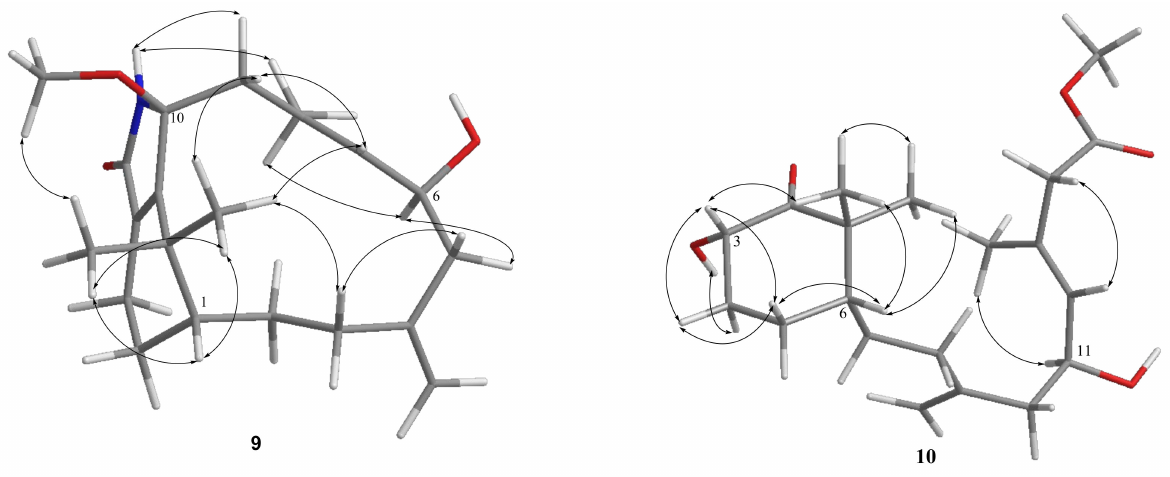
Figure 9. Selected NOE correlations of compounds 9 and 10